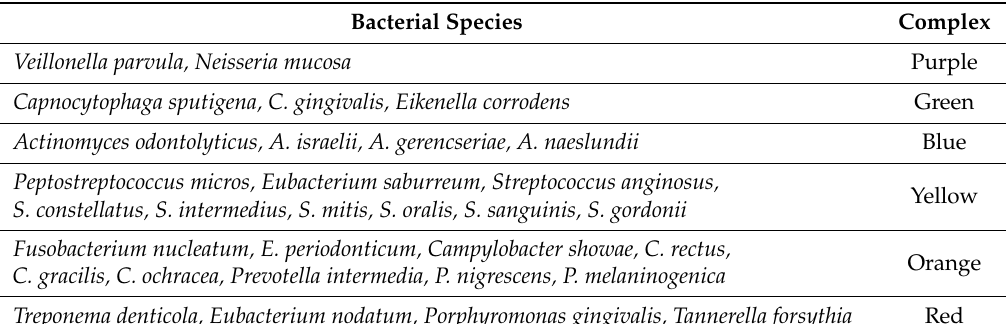
Table 2. Classification of supragingival bacterial complexes